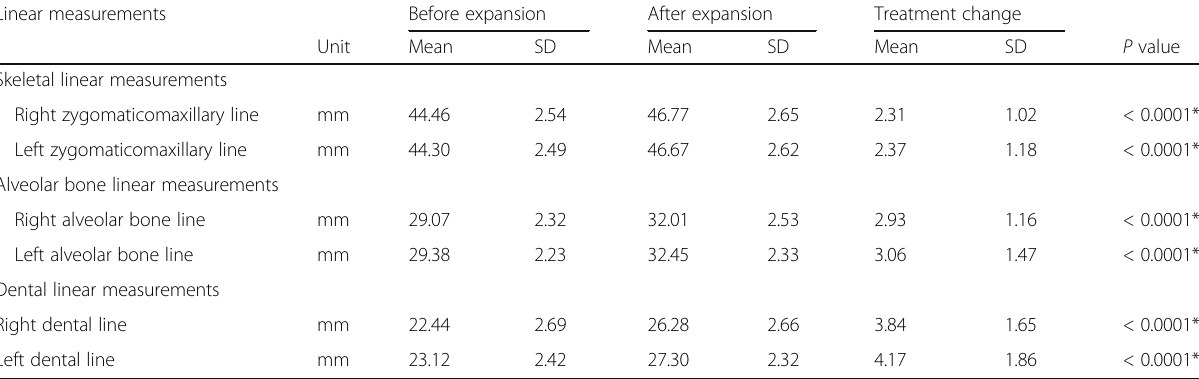
Table 1 Skeletal, alveolar bone, and dental linear measurements Linear measurements Before expansion After expansion Treatment change Skeletal linear measurements Right zygomaticomaxillary line Alveolar bone linear measurements Right alveolar bone line